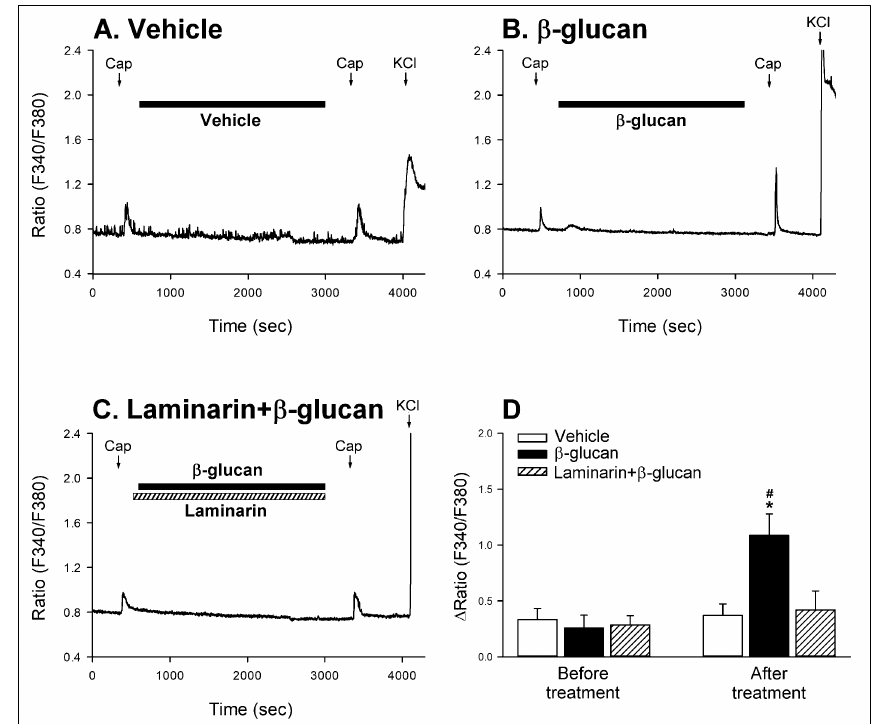
Figure 8. Experimental records illustrating the potentiating effect of β-glucan on capsaicin-evoked Ca 2+ transients and the role of Dectin-1 receptors in this potentiating effect of β-glucan in isolated CSLV neurons. ( A ) and ( B ): perfusion with vehicle (ECS; filled horizontal bar) or β-glucan (200 μg/mL, 40 min; filled horizontal bar), respectively. Capsaicin (Cap, 0.1 μM, 30 sec; arrows) was applied